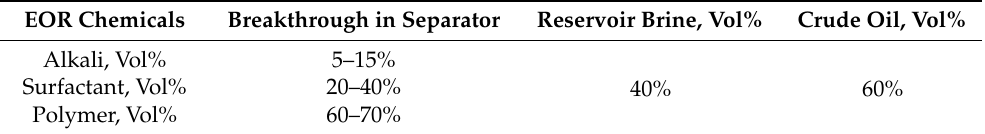
Table 6. Breakthrough of the alkali-surfactant-polymer concentration in the primary